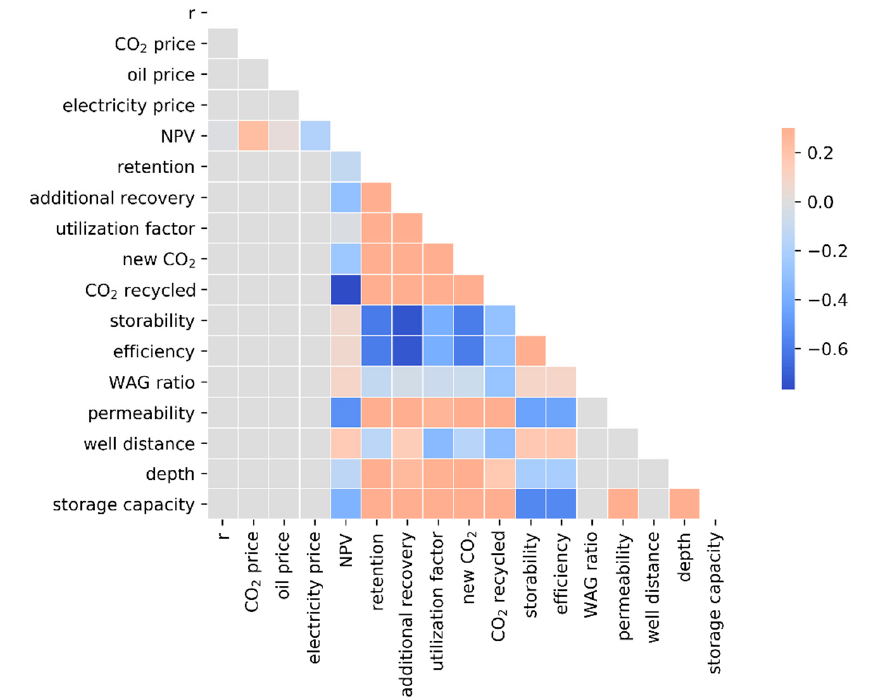
Figure 22. Diagonal correlation matrix.